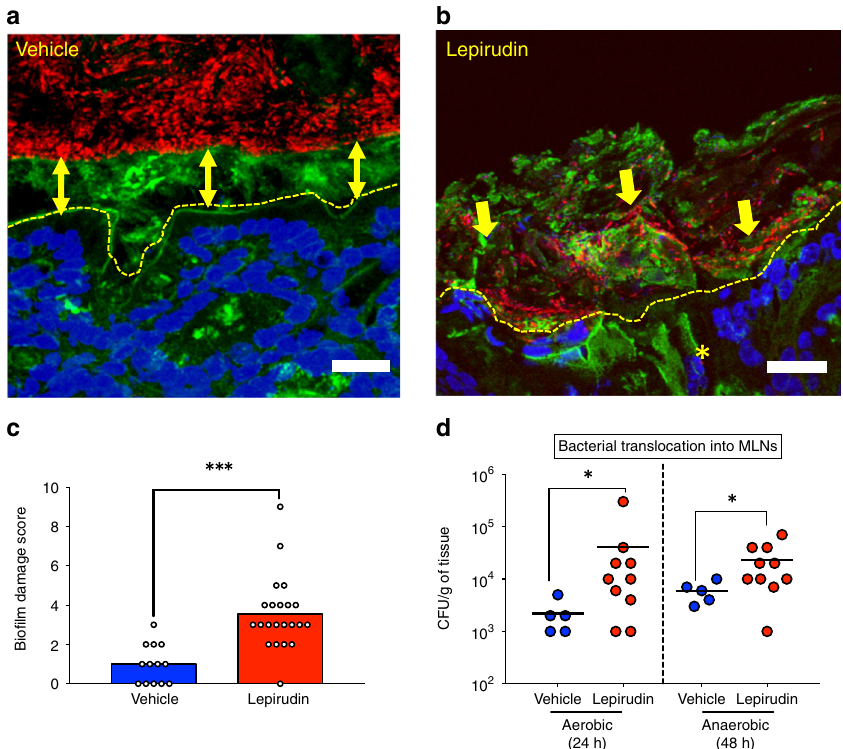
Fig. 4 Suppression of basal thrombin activity modi fi es spatial organization of microbiota bio fi lm. C57Bl/6 mice were treated daily with either vehicle ( n = 5) or lepirudin ( n = 10, 10 µ g per day) via intracolonic route, euthanized after 10 days. a , b Distal colon sections were Carnoy ’ s fi xed. All bacterial cells were labeled with the universal probe Eub338 for fl uorescent in situ hybridization (red color). Wheat germ agglutinin was used to stain the polysaccharides-rich mucus layer on these samples (green color). All images were counterstained with the nuclear stain, 4 ’ ,6-diamidino-2-phenylindole DAPI (blue color). a In vehicle-treated colon, double-arrows highlights the presence of sterile mucus layer separating the colon epithelium (dashed line) from the dense microbiota bio fi lm. b In contrast, lepirudin-treated animals were characterized by a complete disorganization of microbial bio fi lms and mucus layer in distal colon. Adherent and isolated microcolonies were evident (arrows) and rods were visible in submucosal tissue (asterisks). Images are representative of n = 5 mice. Scale bars represent 20 μ m. c Abnormal alterations to gut microbiota bio fi lm organization were blindly recorded and demonstrated an increased damage score in animals treated with lepirudin compared to vehicle control groups. Data are represented as scatter plot with the mean bar. Unpaired Mann – Whitney two-tailed t test *** P < 0.001. d Bacterial translocation, of aerobes and anaerobes, into mesenteric lymph nodes (MLN) was signi fi cantly greater in animals treated with lepirudin compared to vehicle-treated animals. Data are represented as scatter plot with the mean bar. Unpaired Mann – Whitney two-tailed t test * P <